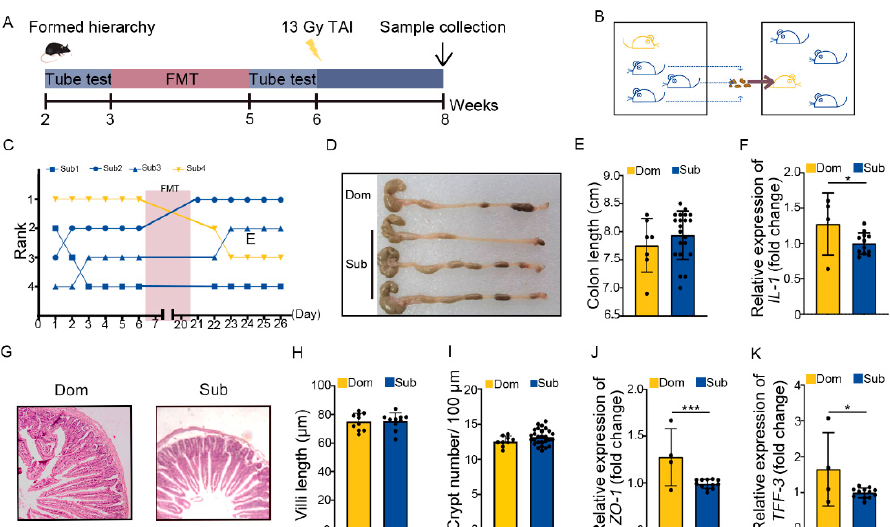
Figure 4. Transplanting gut microbiota from Sub mice to their Dom mouse alleviated intestinal radiation injuries. ( A ) Experimental protocol. ( B ) Schematic of FMT. ( C ) The rank positions of one cage of mice tested daily before and after FMT treatment. ( D ) Photographs of dissected colons from mice in the two groups. ( E ) Statistical comparison of colon length between the two groups. ( F ) The mRNA levels of IL − 1 in small intestinal tissues were examined by qRT − PCR. ( G ) The morphology of small intestine was revealed by H&E staining. ( H ) Length of small intestinal villi in Dom and Sub mice. ( I ) Numbers of small intestinal crypts in Dom and Sub mice. ( J , K ) The mRNA expression levels of ZO − 1 and TFF − 3 in small intestinal tissues were examined by qRT − PCR. Statistically significant dif- ferences are indicated: Student’s t test, n = 4 in Dom group, n = 12 in Sub group, * p < 0.05and *** p < 0.001.